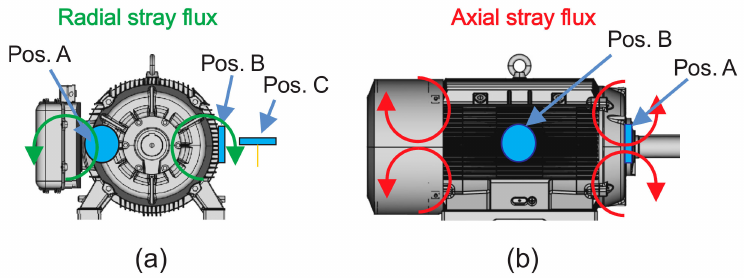
Figure 1. Magnetic stray flux components: ( a ) radial stray flux; ( b ) axial stray flux.